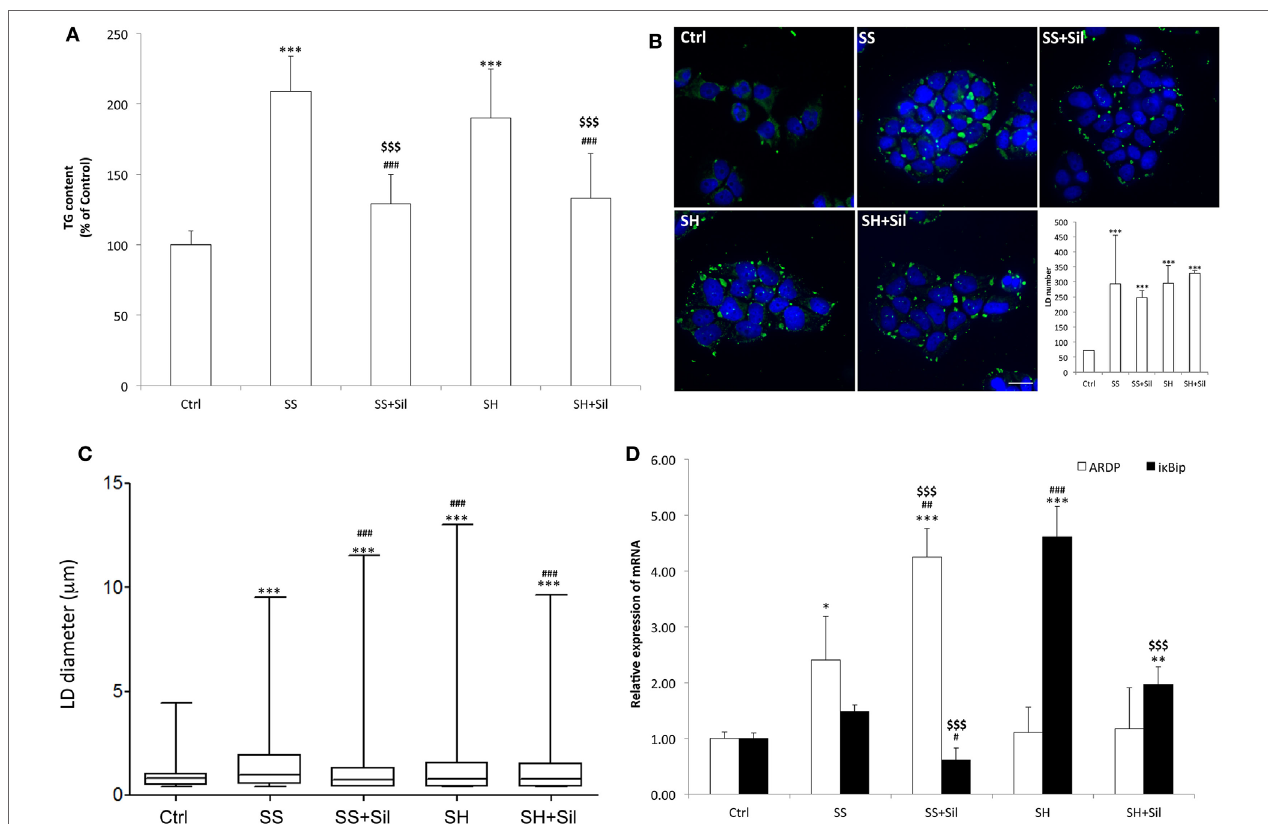
FigUre 1 | Effect of silybin on lipid accumulation. Lipid accumulation parameters were measured in FaO cells incubated in the absence (Ctrl) or in the presence of fatty acids [simple steatosis (SS)] or fatty acids and tumor necrosis factor α (TNF α ) [steatohepatitis (SH)] and subsequently treated with 50 µM silybin (SS + Sil